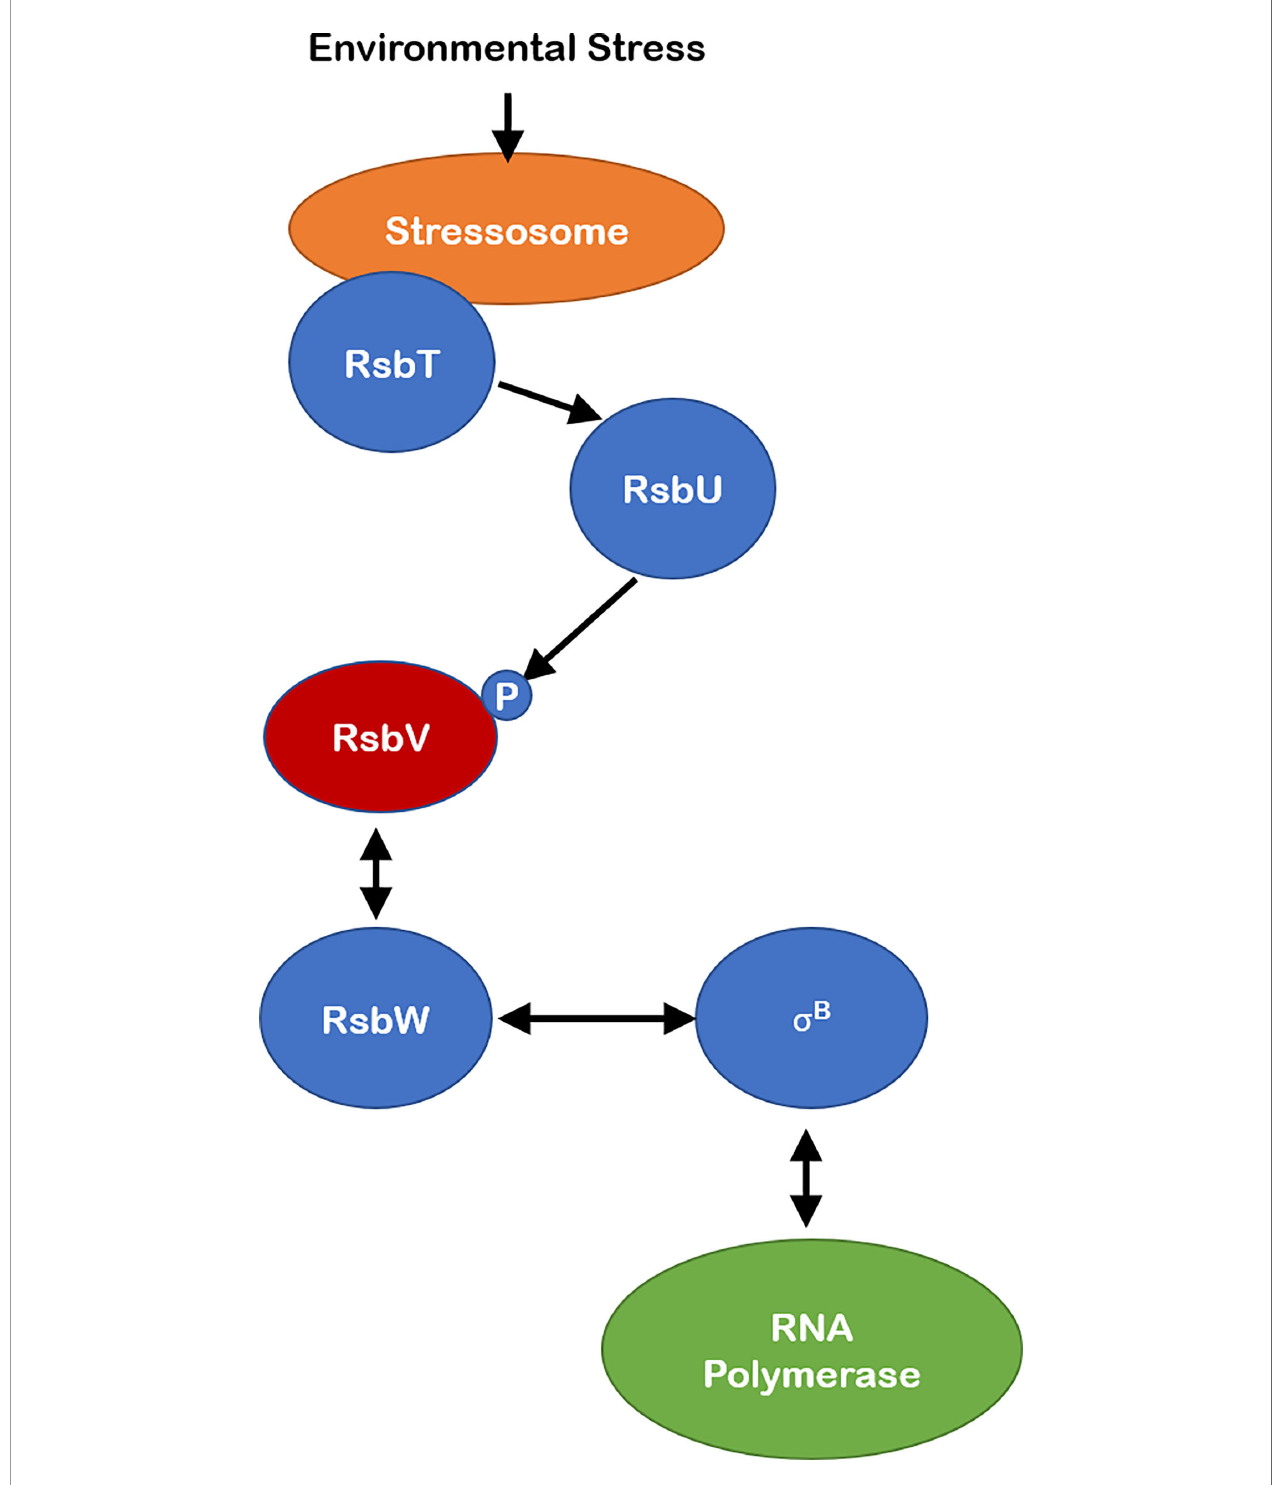
FIGURE 1 | Schematic of canonical SDoP in the Regulation of Sigma B pathway in B subtilis . Environmental stress leads to activation of the stressosome, allowing for activation of the RsbT phosphatase activator. This allows RsbU phosphoserine phosphatase to dephosphorylate a conserved serine residue on SDoP – RsbV- which in its unphosphorylated state interacts with anti-sigma factor RsbW, freeing s B to bind the core RNA polymerase and initiate transcription of genes in the general stress response operon. The anti-sigma factor RsbW possesses serine kinase activity such that when the environmental stress is no longer present RsbV is phosphorylated, leading to its dissociation from RsbW. RsbW then sequesters s B , leading to decreased expression of its operon.